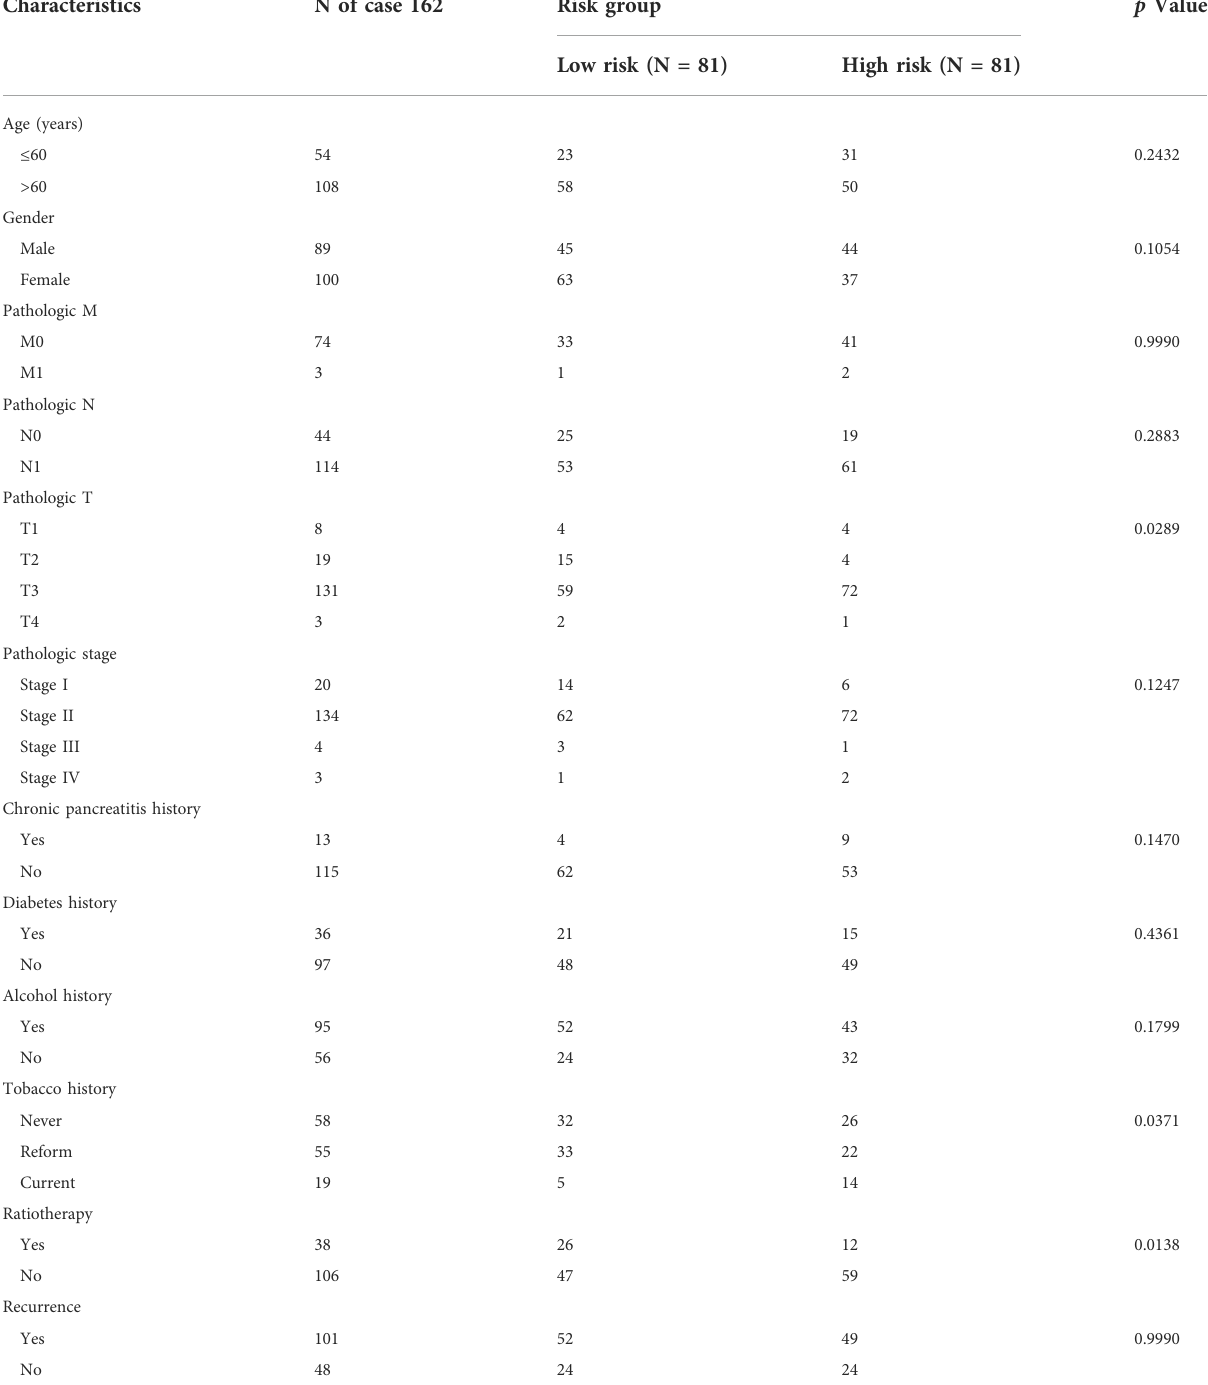
TABLE 1 Clinical characteristics and pathological parameters of PAAD